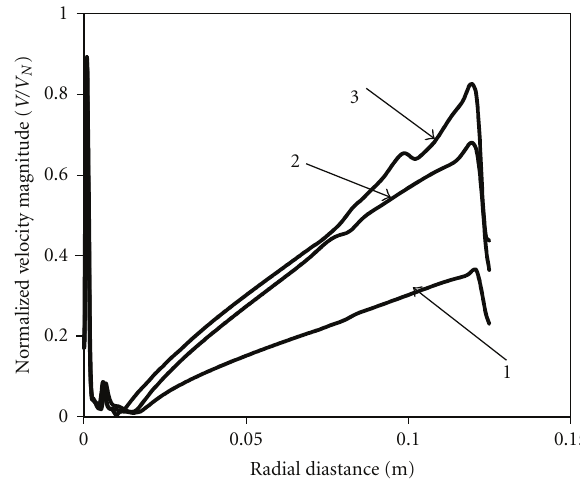
Figure 2: Variation of normalized velocity magnitude ( V/V N ) along radial coordinate [ z = 0 . 00075 m] disc diameter: 0.15 m, flow rate: